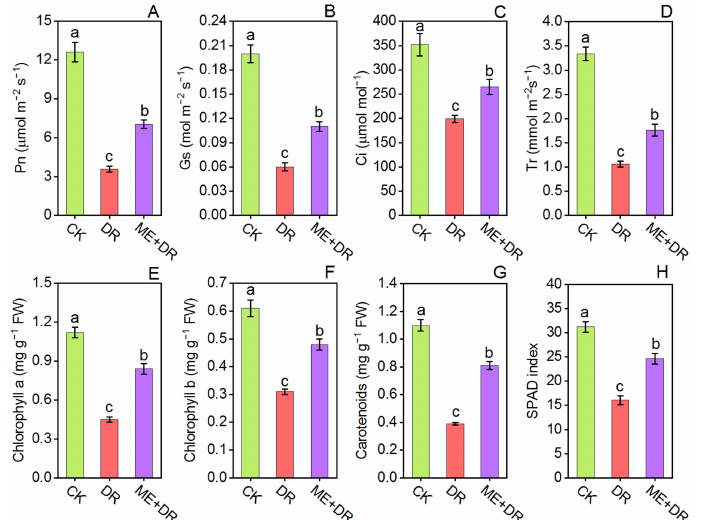
Figure 3. Exogenous supplementation of melatonin promoted leaf gas exchange [Pn ( A ), Gs ( B ), Ci ( C ) and Tr ( D )] and level of pigment [chlorophyll a ( E ), chlorophyll b ( F ), carotenoids ( G ), and SPAD index ( H )] of tomato leaves under drought stress conditions. Means ± standard error, n = 3, significant differences are exhibited by lowercase letters ( p ≤ 0.05), according to LSD